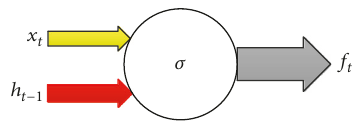
Figure 5: Architecture of the forget gate in